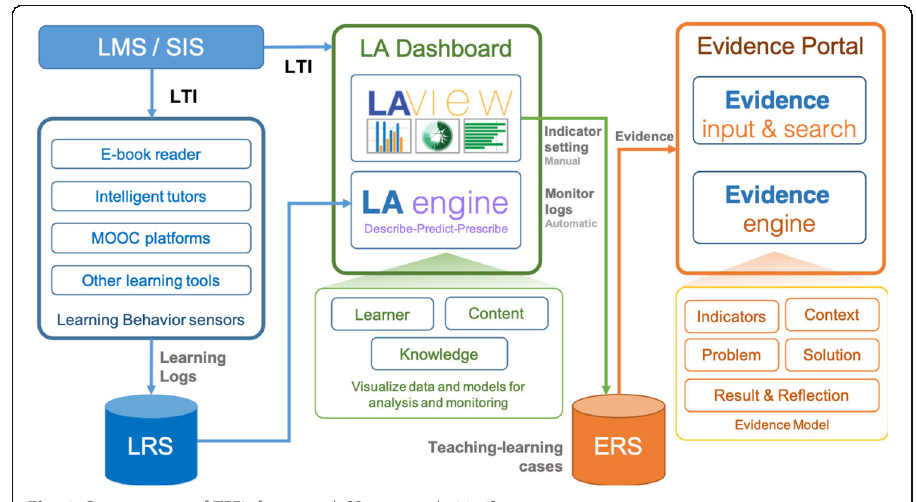
Fig. 2 Components of TEEL framework [Ogata et al.,